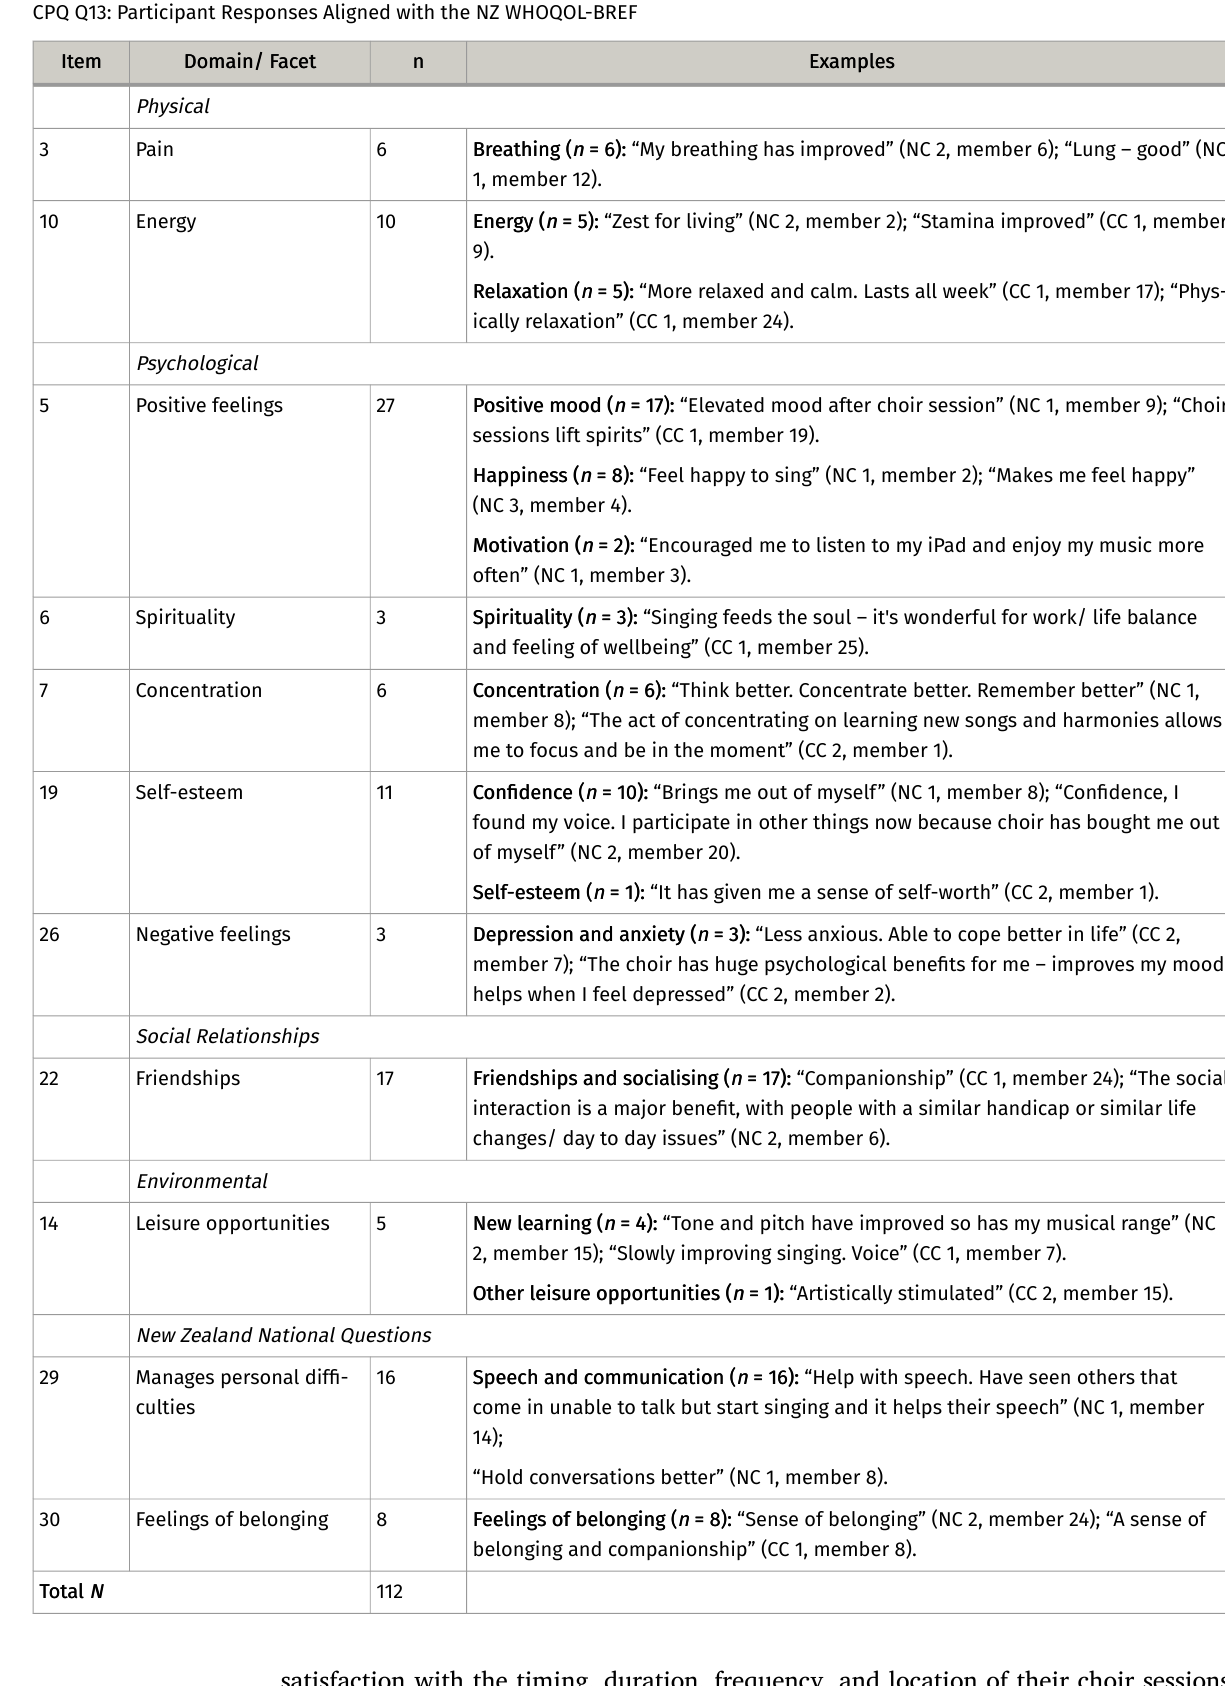
FFeelingeelings of bels of belonging (onging (nn= 8):= 8): “Sense of belonging” (NC 2, member 24); “A sense of belonging and companionship” (CC 1, member